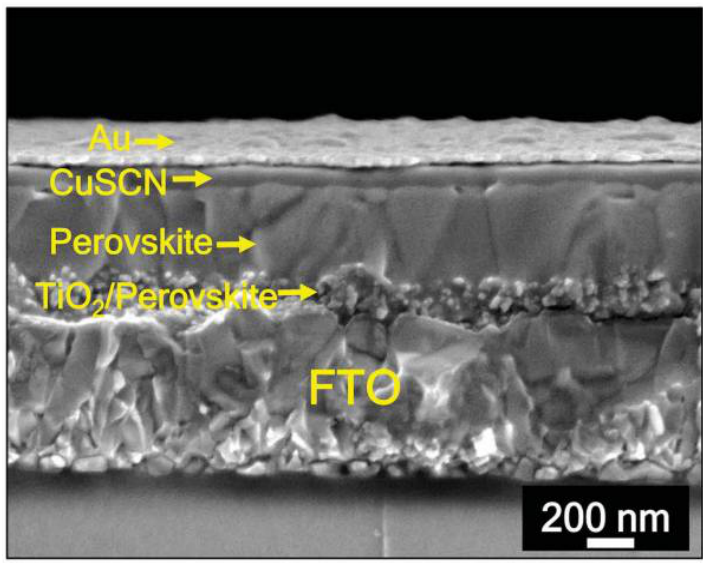
Figure 6. SEM images of the PSC with CuSCN and CuSCN/rGO as HTLs [54].